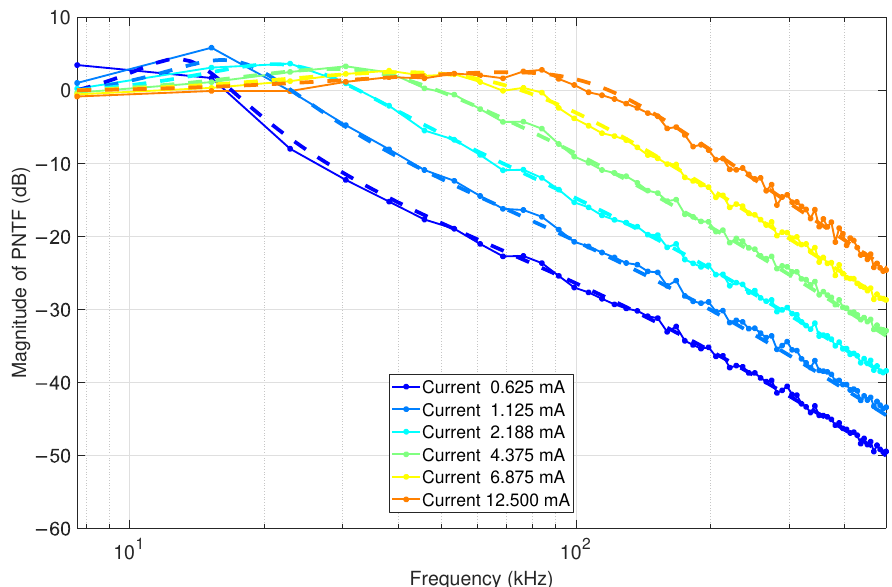
Figure 8. The magnitude of the measured (solid lines with dots) and modeled (dashed lines) PNTF characteristics of the LMX2592 for the selected charge pump current values. Reference frequency 125 MHz, output frequency 1 GHz, and VCO frequency 4